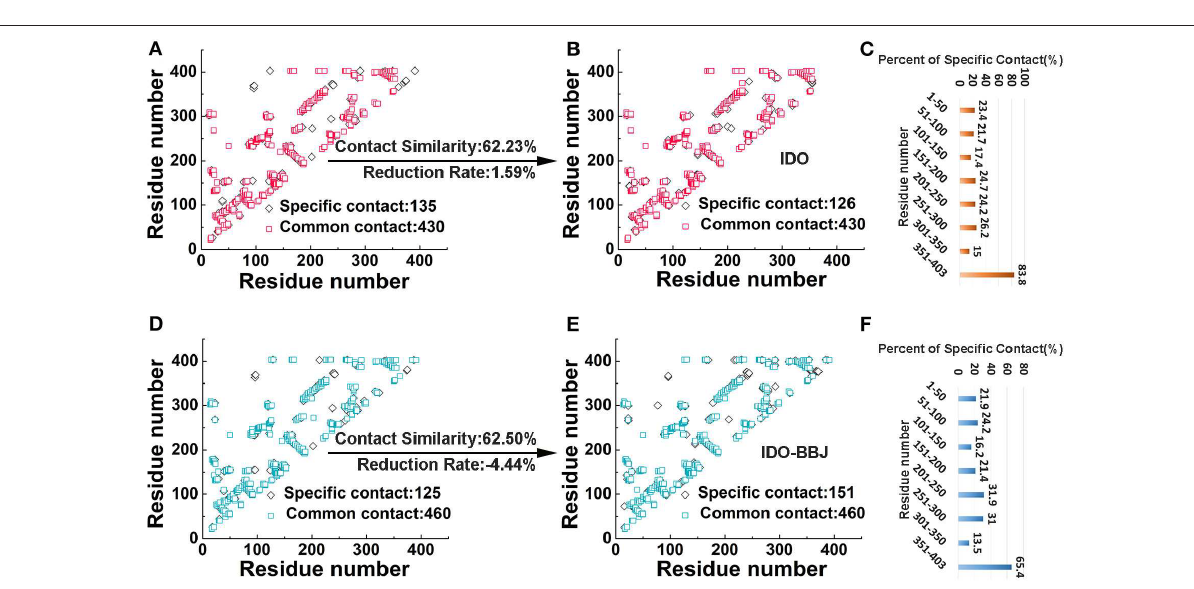
FIGURE 3 | Comparative analyses of residue contacts in the IDO (colored in red and orange) and IDO-BBJ systems (showed in light blue and blue): residue contacts maps (A,B,D,E) , and percent of specific residue contacts in the two investigated systems (C,F)